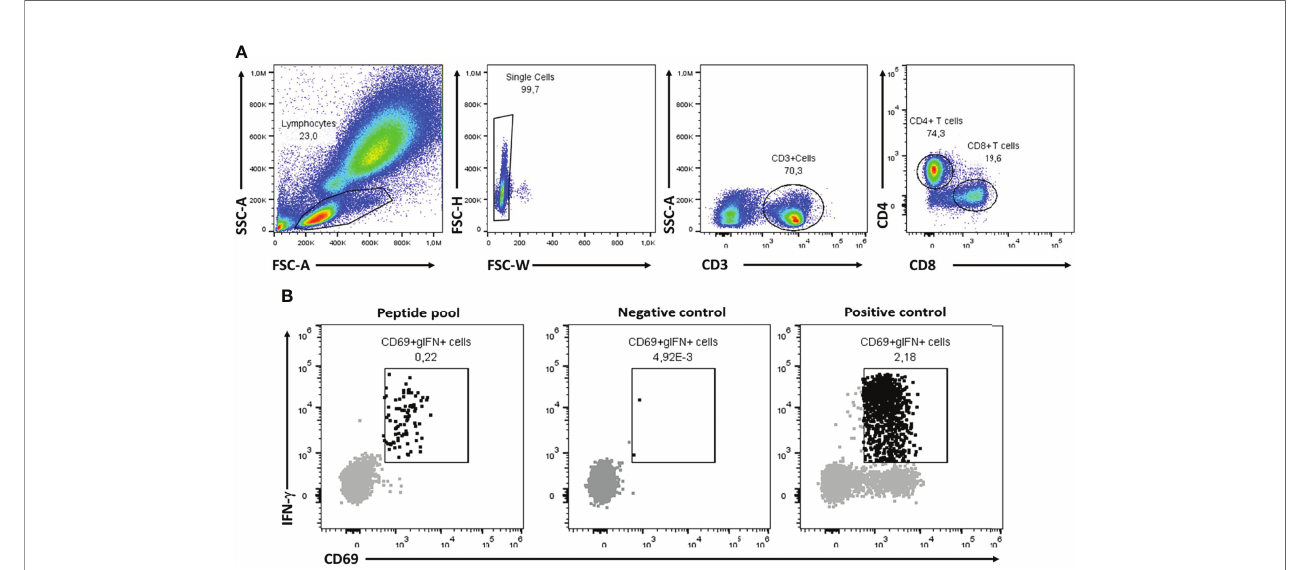
FIGURE 2 | Representative fl ow cytometry analysis for CoVITEST. The fl ow cytometry gating strategy was performed sequentially; lymphocyte complexity (SSC vs. FSC), single cell, CD3+ and fi nally either CD4+ or CD8+ (A) . From there, 40,000 CD4+ or CD8+ T cells were further evaluated for CD69 and IFN- g expression in S and N peptide pool, negative control (vehicle) and positive control (SEB) samples to determine the T cell reactivity for each donor (B)